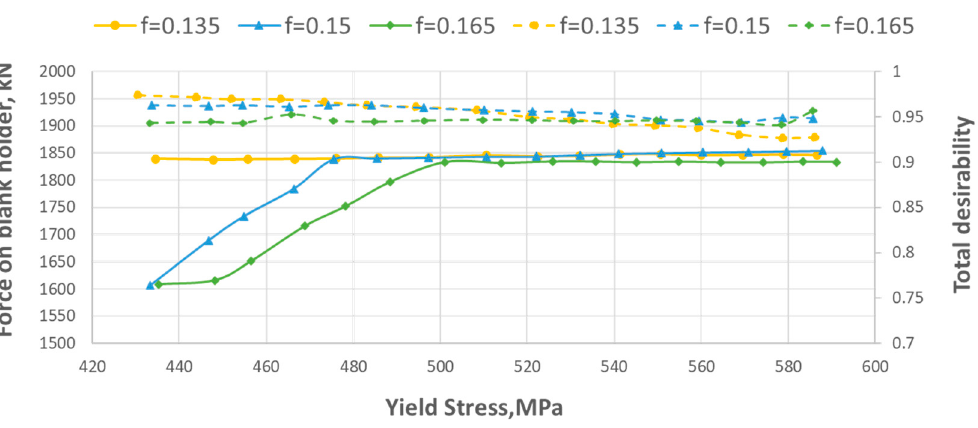
Figure 14. Regulation and total desirability curves.